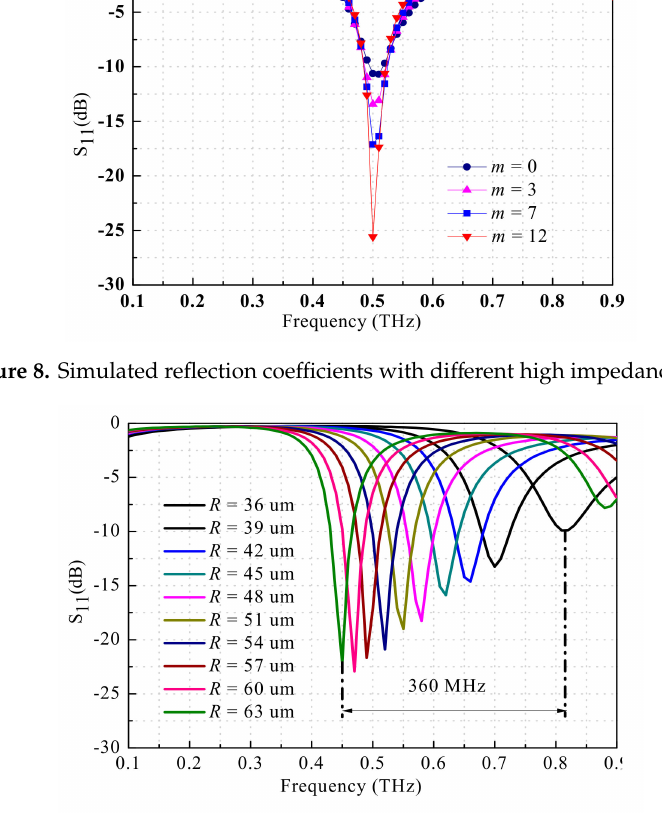
Figure 9. Simulated reflection coe ffi cients of the loop antennas with di ff erent